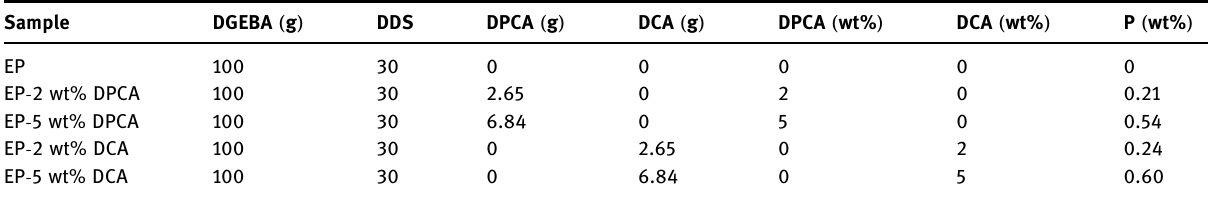
Table 1: The detailed formulation of EP, EP – DPCA, and EP – DCA materials